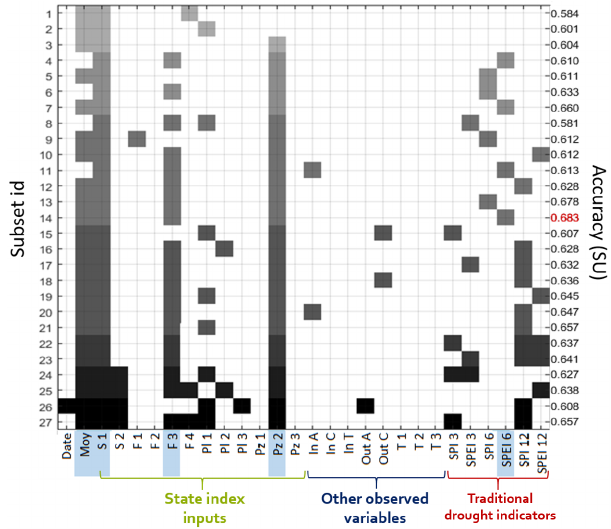
Figure 5. Selection matrix: the left vertical axis represents the sub- set number (id) and the right vertical axis the corresponding accu- racy measured in SU. A colored marker is put in correspondence with the variables, listed on the horizontal axis, selected by each subset. The shade of gray is an indication of the cardinality of the subset, lighter shades for lower cardinality. The highest accuracy is reported in red and the corresponding variables, constituting the most accurate subset, have a blue